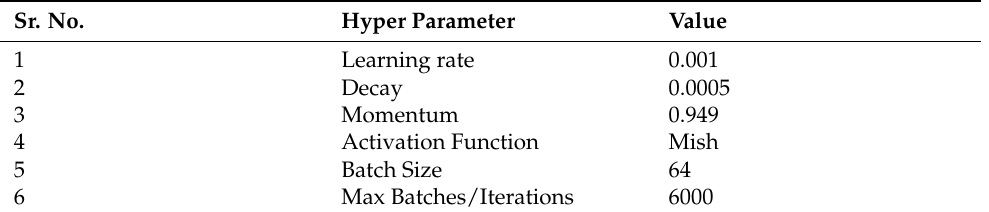
Table 2. Scaled-YOLOv4 Default Hyperparameters Settings for Models Training. Sr.